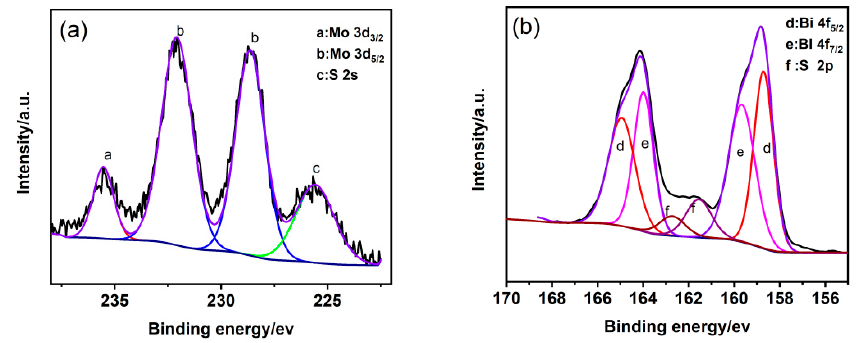
Figure 5. XPS spectra orbits of the Mo–Bi BMC-15% Nanocomposites. ( a ) Mo 3 d and S 2 s , ( b ) Bi 4 f and S 2 p .